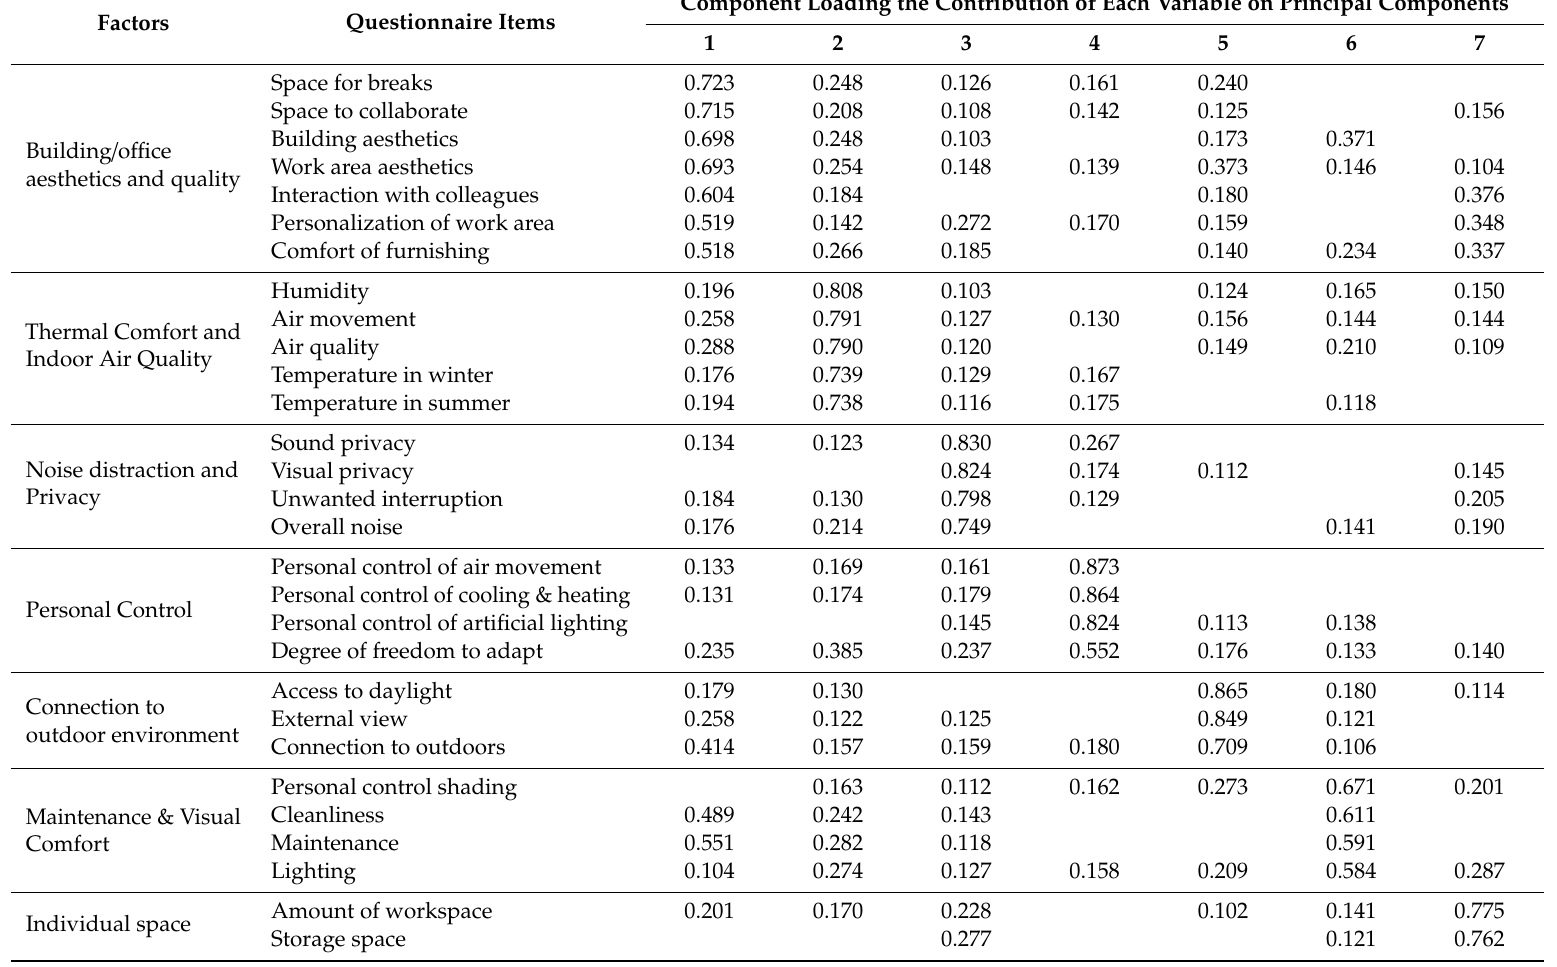
Table 1. Component loading of each factor and questionnaire